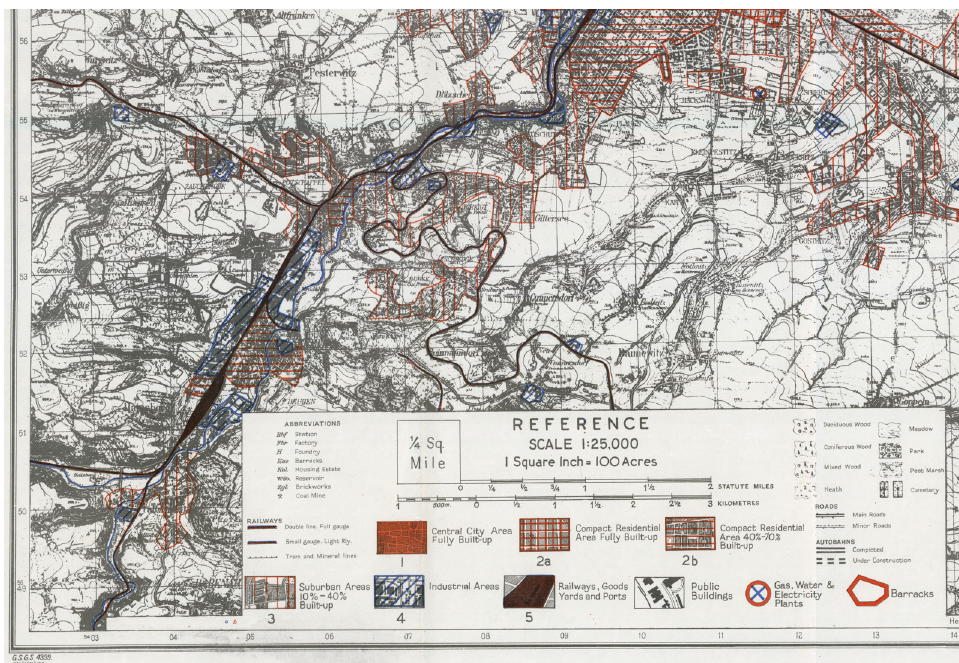
Fig. 5. Part of a British chart of Dresden at the scale of 1:25,000 (published by GSGS), intended to be used by pilots for bombing the city; developed on the basis of a German chart ( Messtischblatt